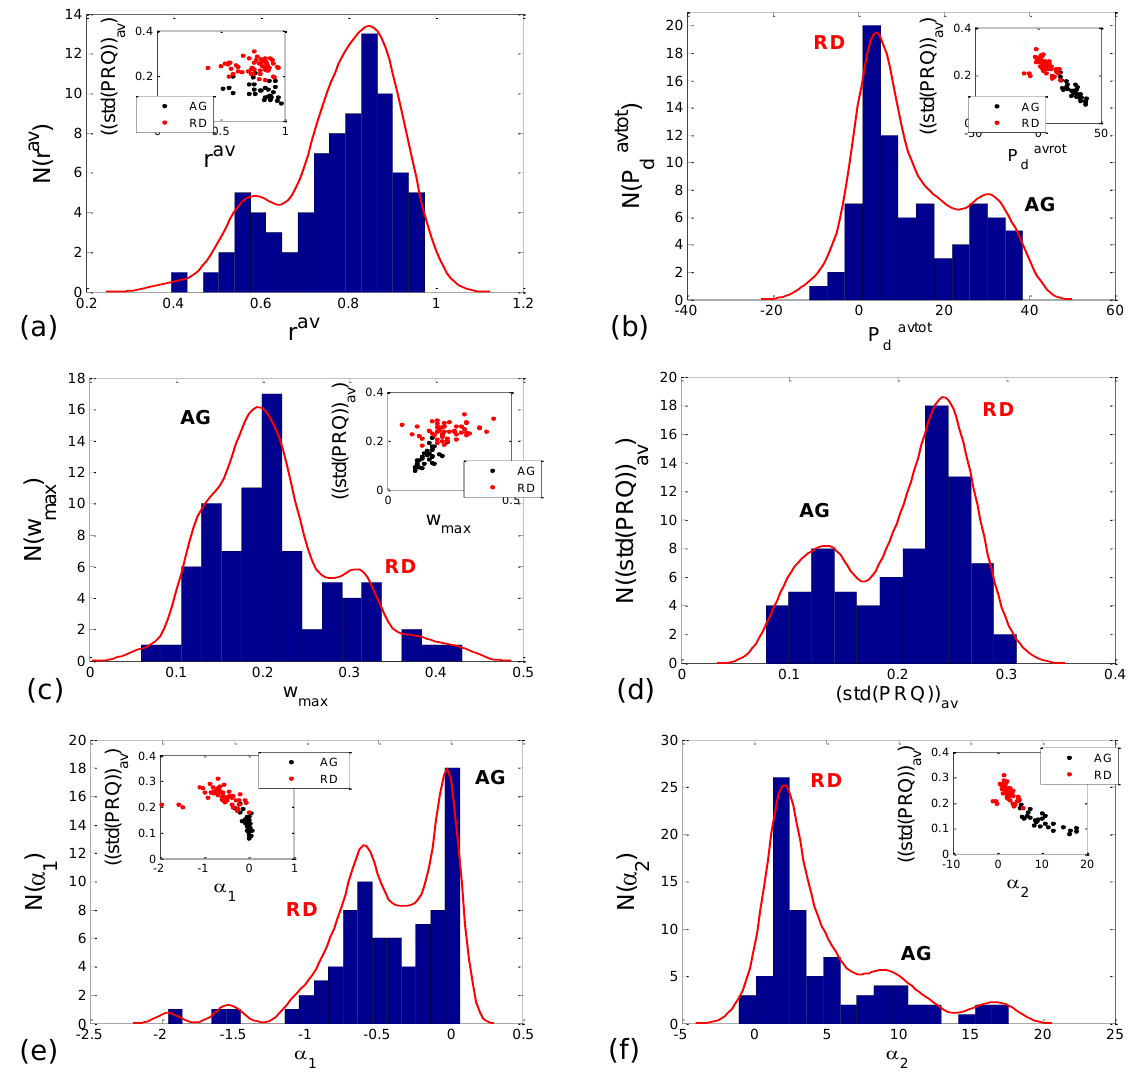
Figure 11. ( a – f ) Histograms approximating the distributions of 80 (20 subjects × 4 states) BBI vs. mRRI scatter plots over six proposed measures of aggregation of the points around the PRQ int lines. Corresponding PDE distributions are drawn as red solid curves. Except in the case of r av , all other five measures were pointing to two types of scatter plots (AG and RD), which is in accordance with the results in Figure 10 and Table 1 and can be assumed by the previous visual observation. Inlets show the correlations between a particular measure and (std( PRQ )) av , where each dot represents one scatter plot, color-coded to correspond to one of two visually assessed subtypes (AG or RD).